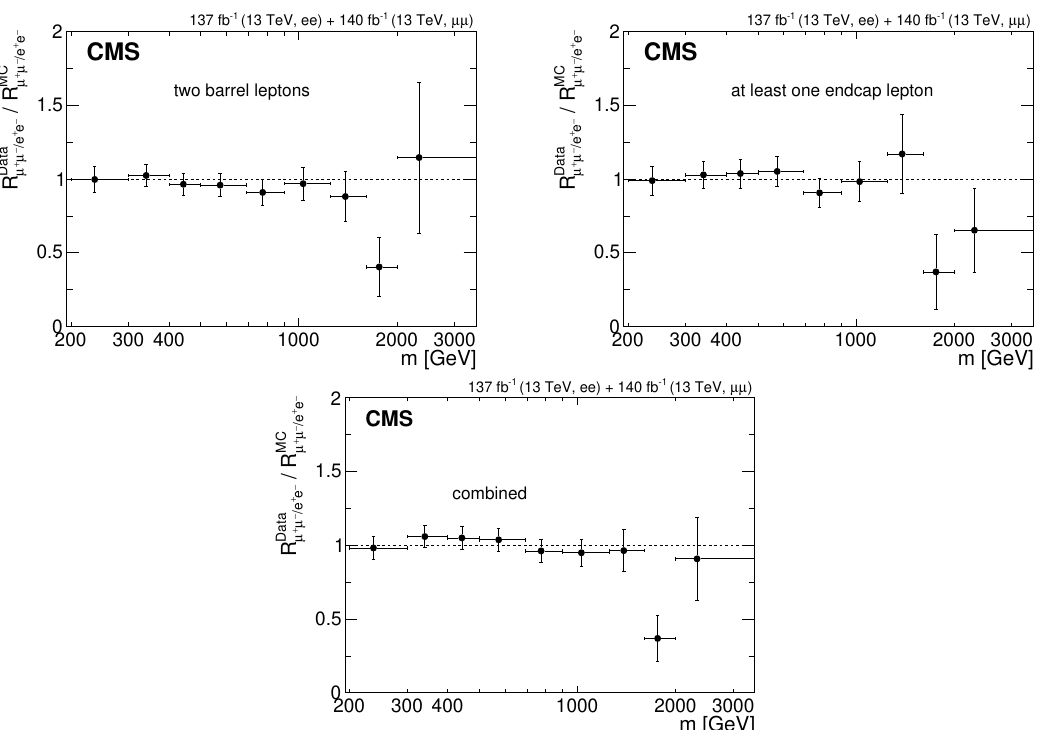
Figure 12 . Ratio of the differential dilepton production cross section in the dimuon and dielectron channels R , as a function of m for (upper left) events with two barrel leptons, (upper + − / e+ e − ‘‘ m m right) at least one lepton in the endcaps, and (lower) their combination. The ratio is obtained after correcting the reconstructed mass spectra to particle level. The error bars include both statistical and systematic